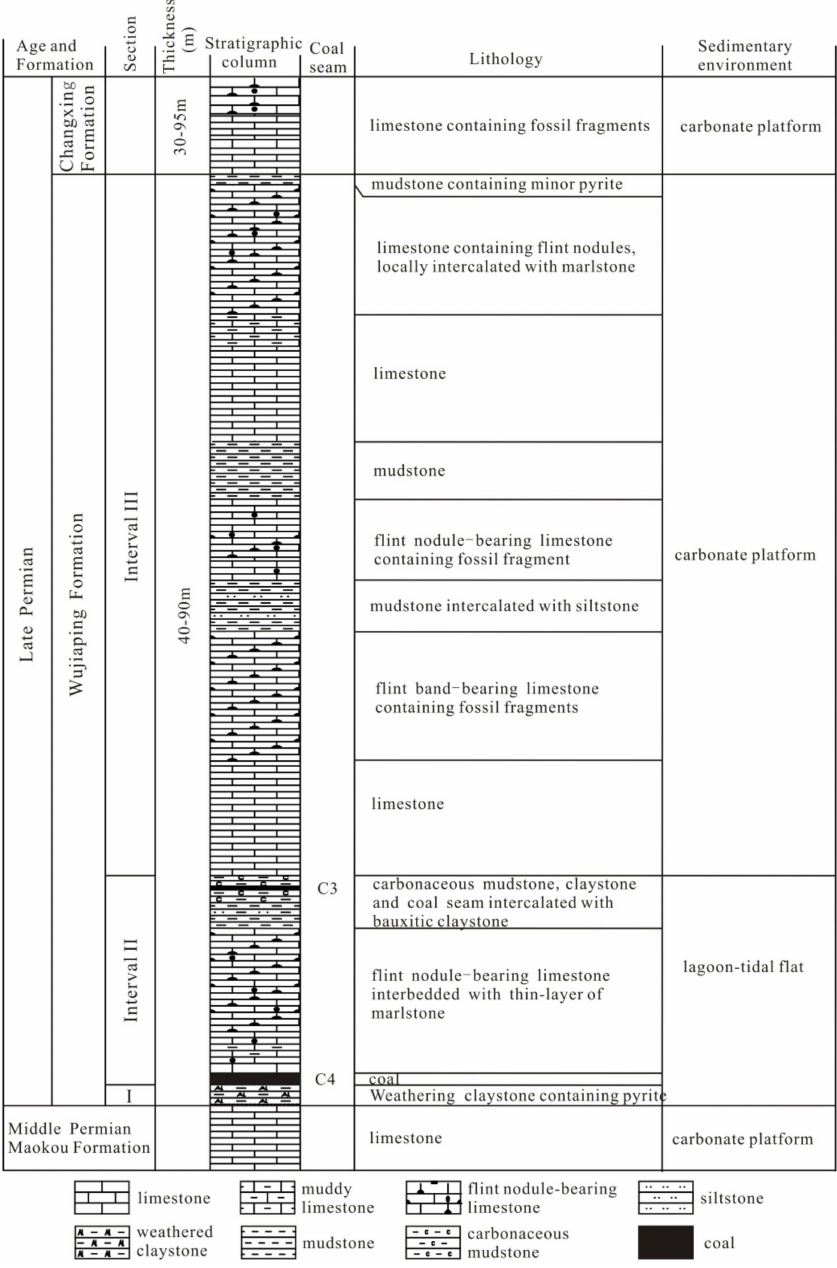
Figure 2. Sedimentary sequence of the Late Permian Wujiaping Formation in the Tongzi Coalfield (Based on the exploration data from Guizhou Province Geology and Mineral